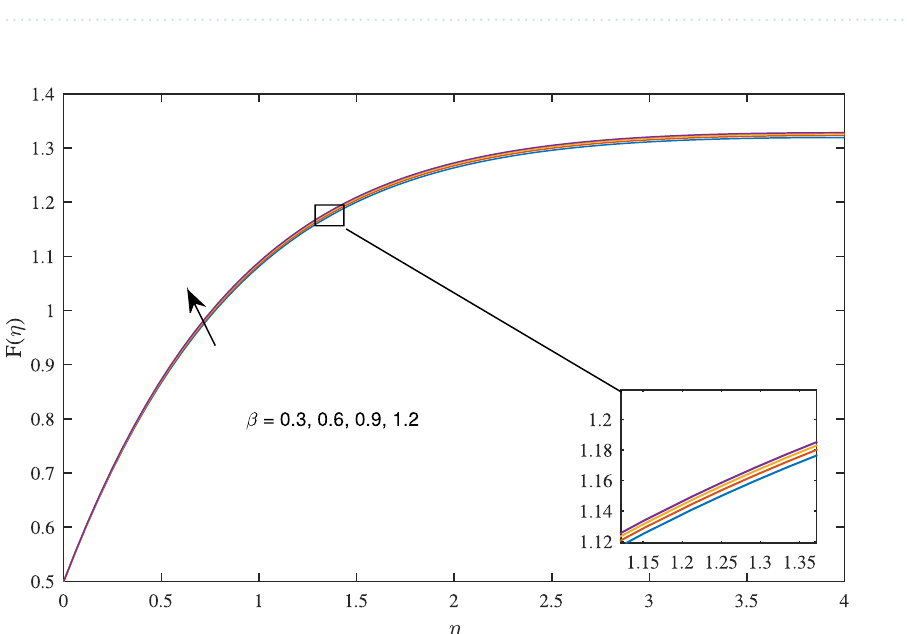
1 , w 0.5 , β 0.2 , N 0.2 , rd = = = ◦ =